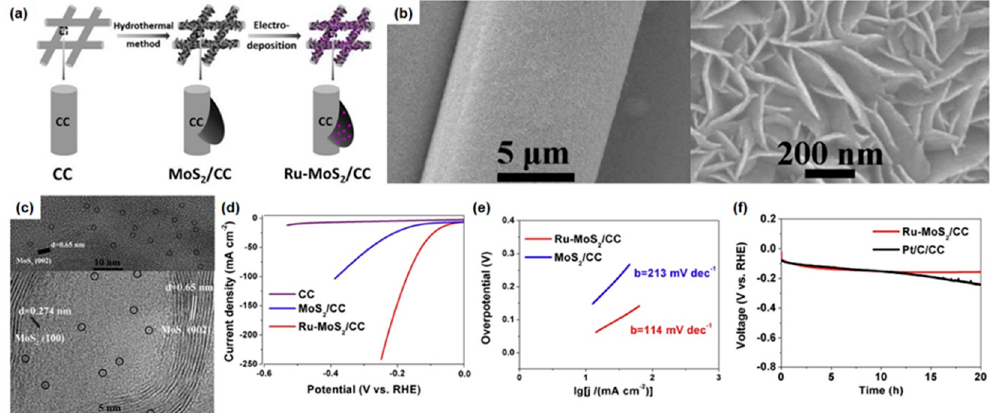
Figure 6. ( a ) The fabrication process of Ru-MoS 2 /carbon cloth array catalyst. ( b ) SEM images of Ru-MoS 2 /CC nanosheet. ( c ) HR-TEM images of Ru-MoS 2 /CC (single Ru atoms are marked by black circles). ( d ) Polarization HER curves of bare CC, MoS 2 /CC, and Ru-MoS 2 /CC (Ru loading: 46 µg/cm 2 ) in 1.0 M KOH solution. ( e ) Tafel plots of MoS 2 /CC and Ru-MoS 2 /CC. ( f ) Chronopotentiometry analysis of long-term stability for Ru-MoS 2 /CC and Pt/C/CC at 10 mA/cm 2 for 20 h. Reprinted (adapted) from [135], copyright (2023) Elsevier B.V.